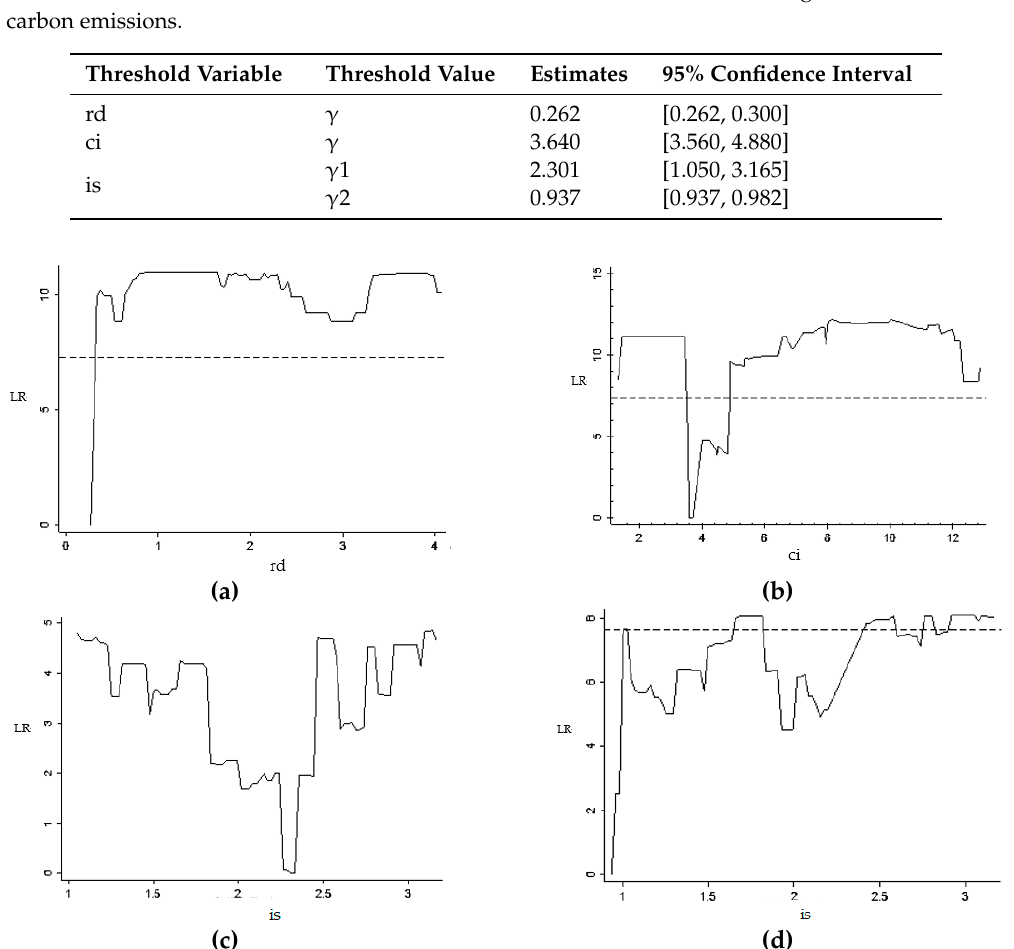
Figure 3. LR value and threshold parameter diagram of foreign investment and carbon emissions. ( a ) rd-single-threshold model; ( b ) ci-single-threshold model; ( c ) is-single-threshold model;